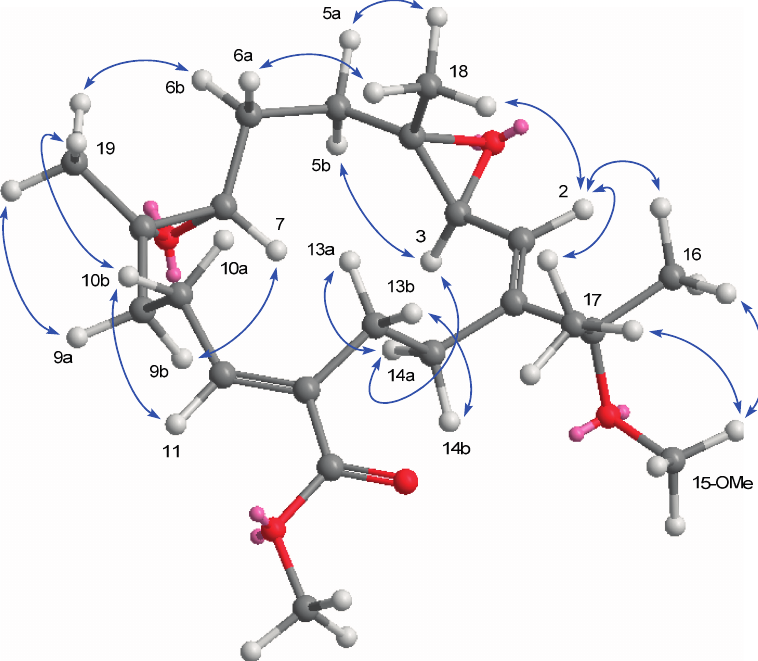
Figure 4. Selected NOESY correlations and computer-generated perspective model using MM2 force field calculations for 3